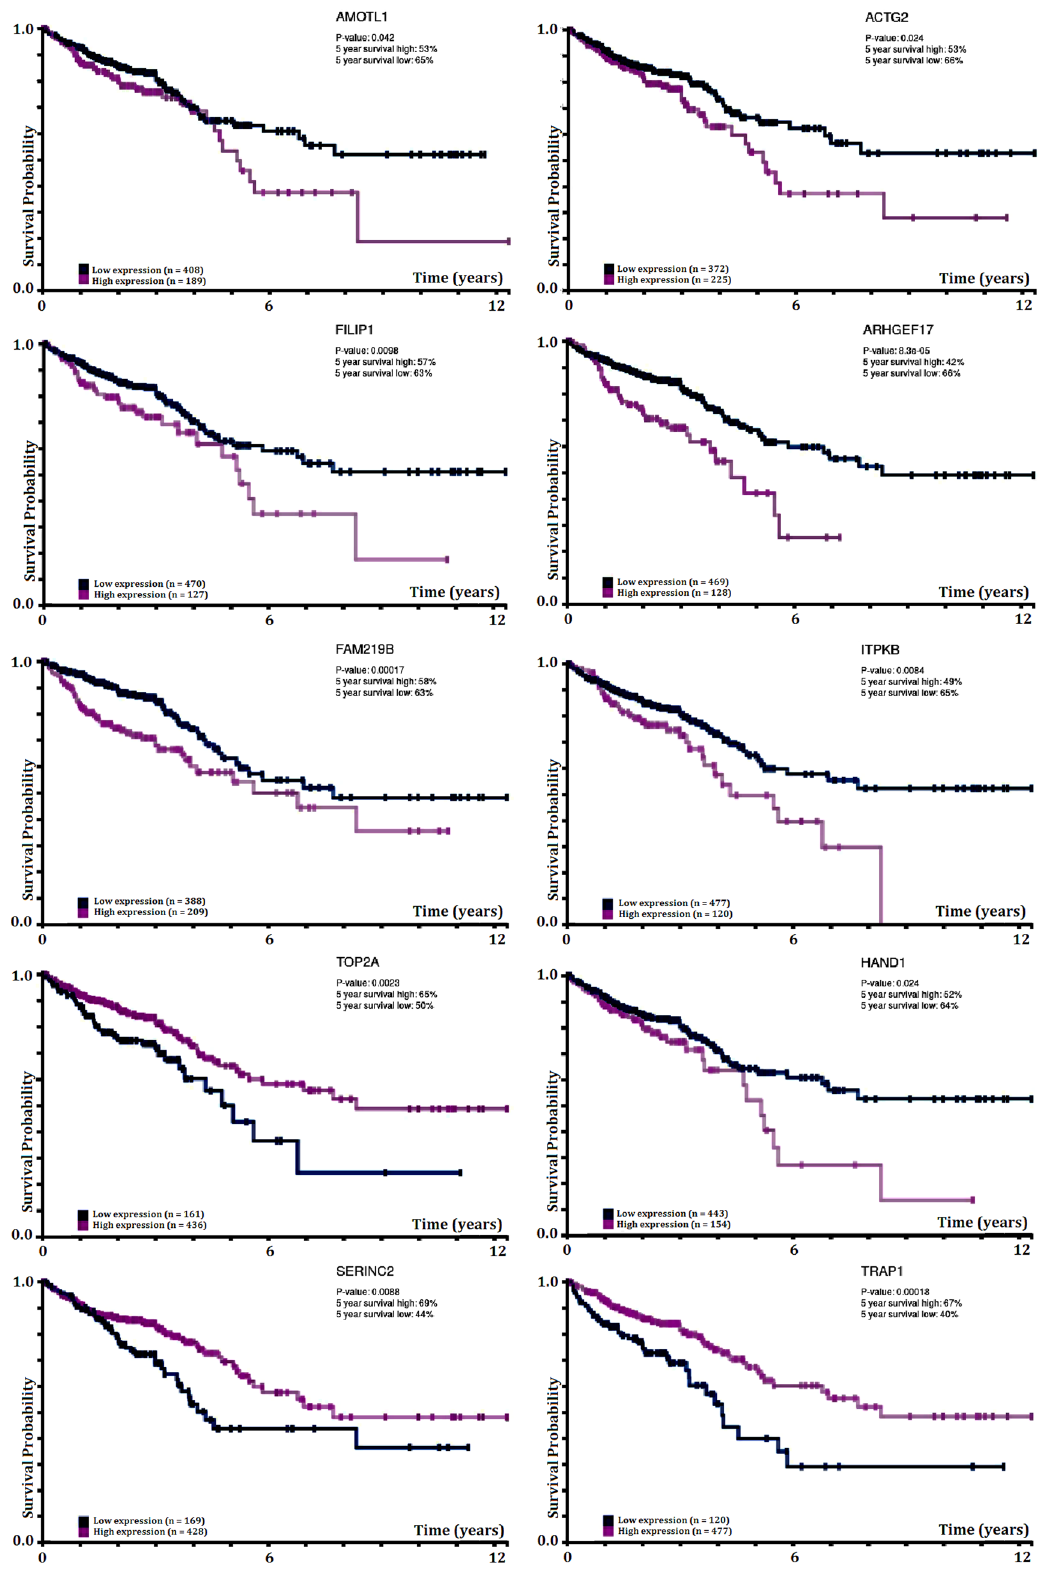
Figure 7. Diapeutics implication of top 10 protein-coding salient genes in CRC. Kaplan–Meier (KM) survival analysis of overall survival with respect to expression of top 10 protein-coding salient genes in CRC samples. In each plot, the abscissa represents ‘Time in Years’ and the ordinate represent ‘Survival Probability’. Log-rank p-value for KM plot represents a significant correlation between mRNA expression level and patient survival by exhibiting significant differences in survival between genes’ high and low expression. Protein-coding salient genes exhibited statistically significant (log-rank p-value ≤ 0.05) in the overall survival endpoint (refer to Supplementary File Figure S1–S10 for enlarged